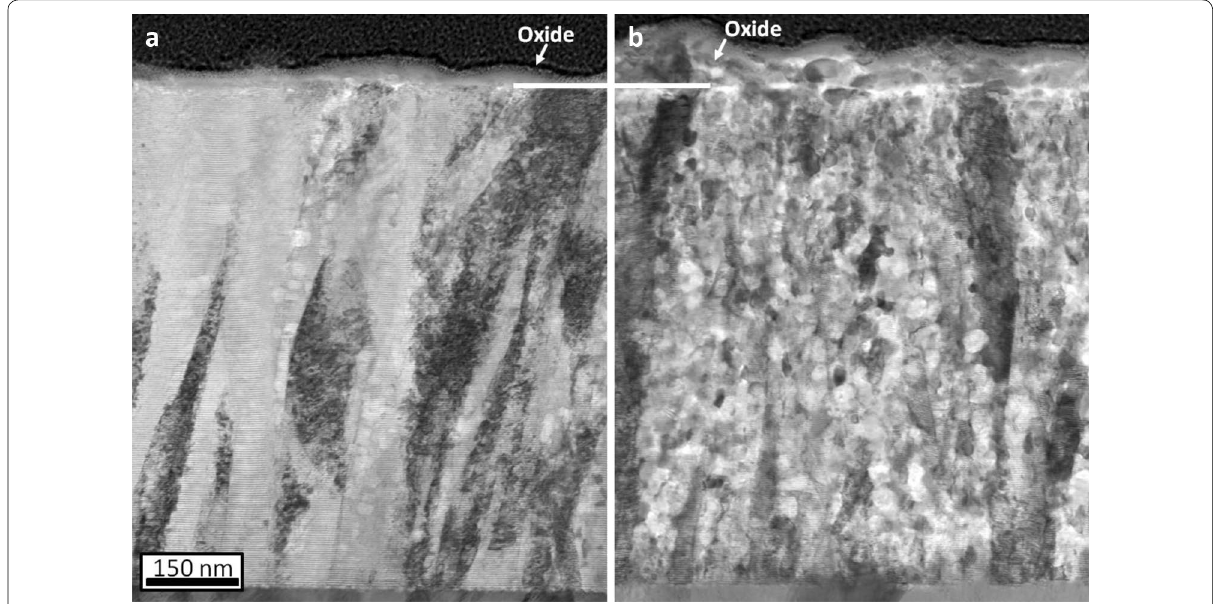
Fig. 3 STEM‑BF cross section views of the coating annealed for 60 min at 900 °C. TEM lamellas were prepared from different regions of the same sample containing a low ( a ) and high ( b ) number density of GB (compare Region 1 and 2 in Fig. 2). Regions with a high number of GBs are subject to pronounced